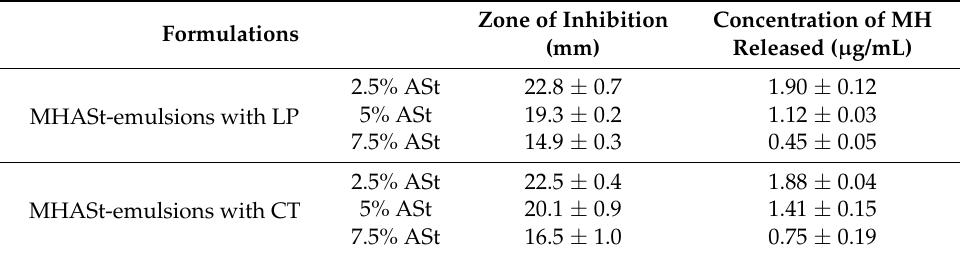
Table 3. Comparison of zone of inhibition produced by MHASt-emulsions after 24 h of incubation (mean ± SD, n =